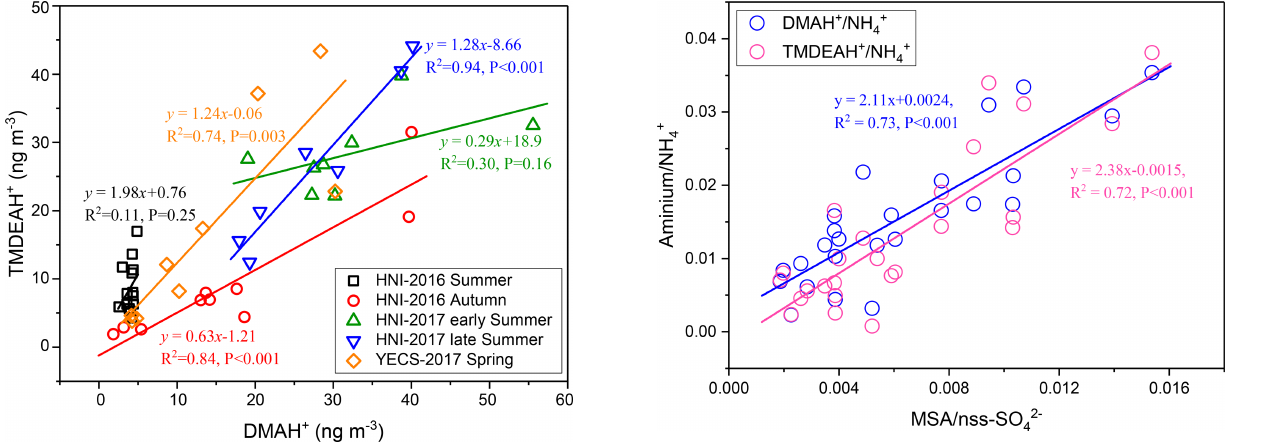
Figure 12. Correlations between DMAH + and TMDEAH + for each campaign over Huaniao Island and the YECS.